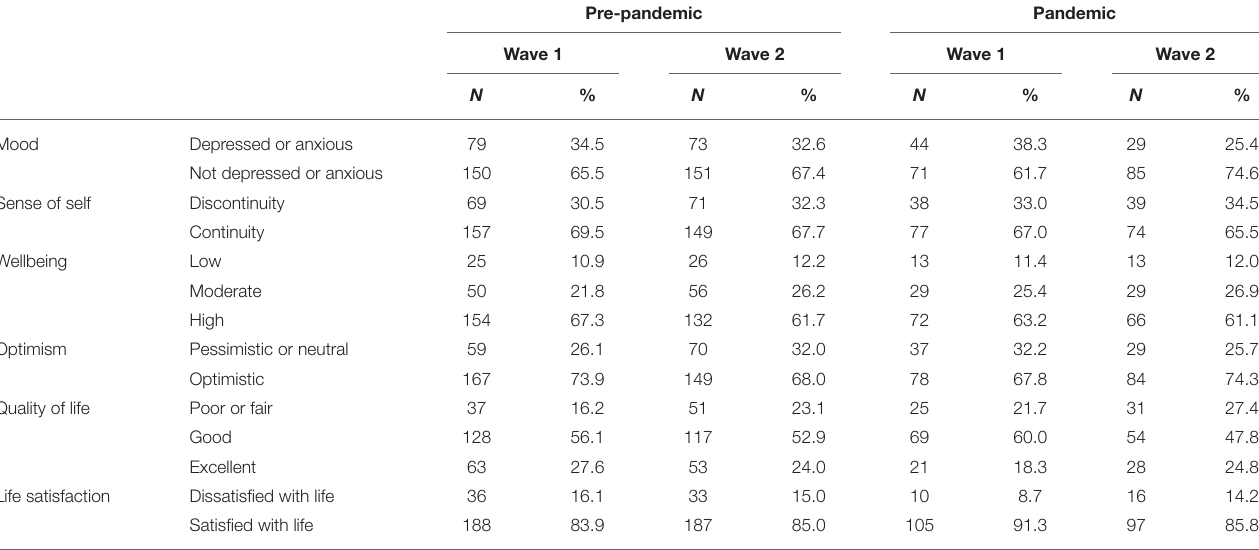
TABLE 2 | Outcomes at wave 1 and wave 2 in the pre-pandemic and pandemic groups.